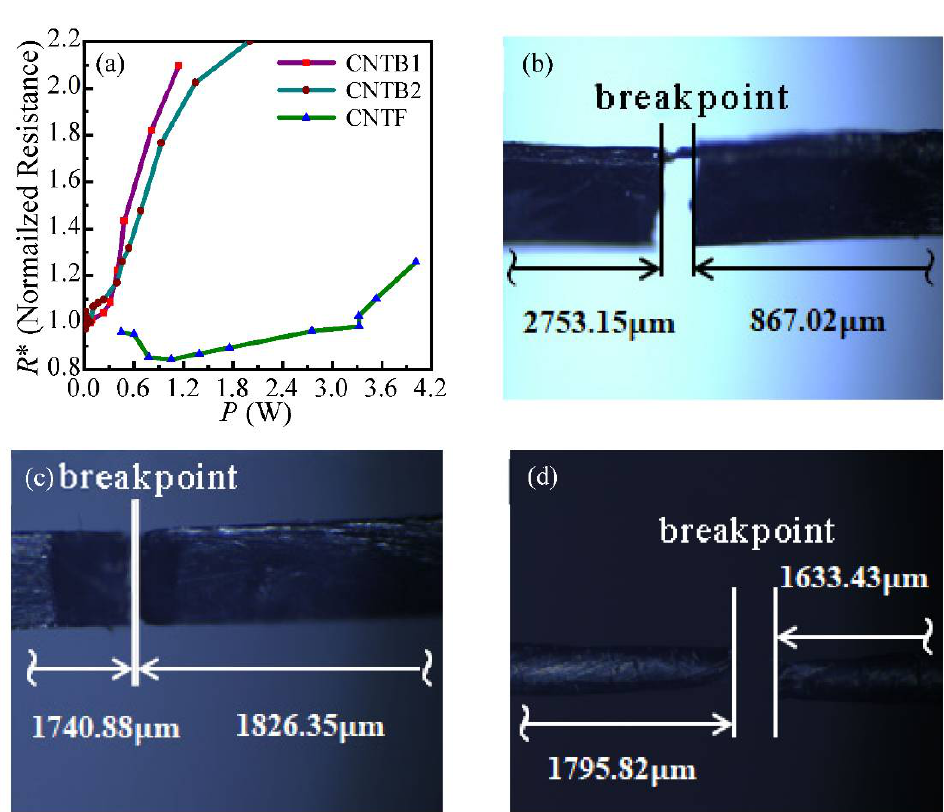
Figure 6. ( a ) Curves of sample-normalized resistance with annealing power. The R * of samples has different degrees of increase with the increase of P . Diagram of burning down after annealing: ( b ) CNTB1; ( c ) CNTB2; ( d ) CNTF. The locations of breakpoints are shown in the figures.